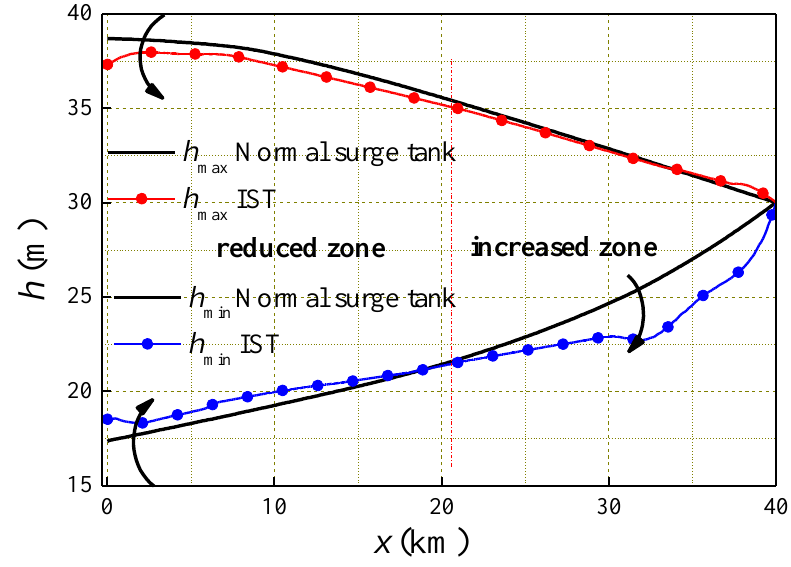
Figure 11. Extreme water head along the pipe after pump failure using the IST.